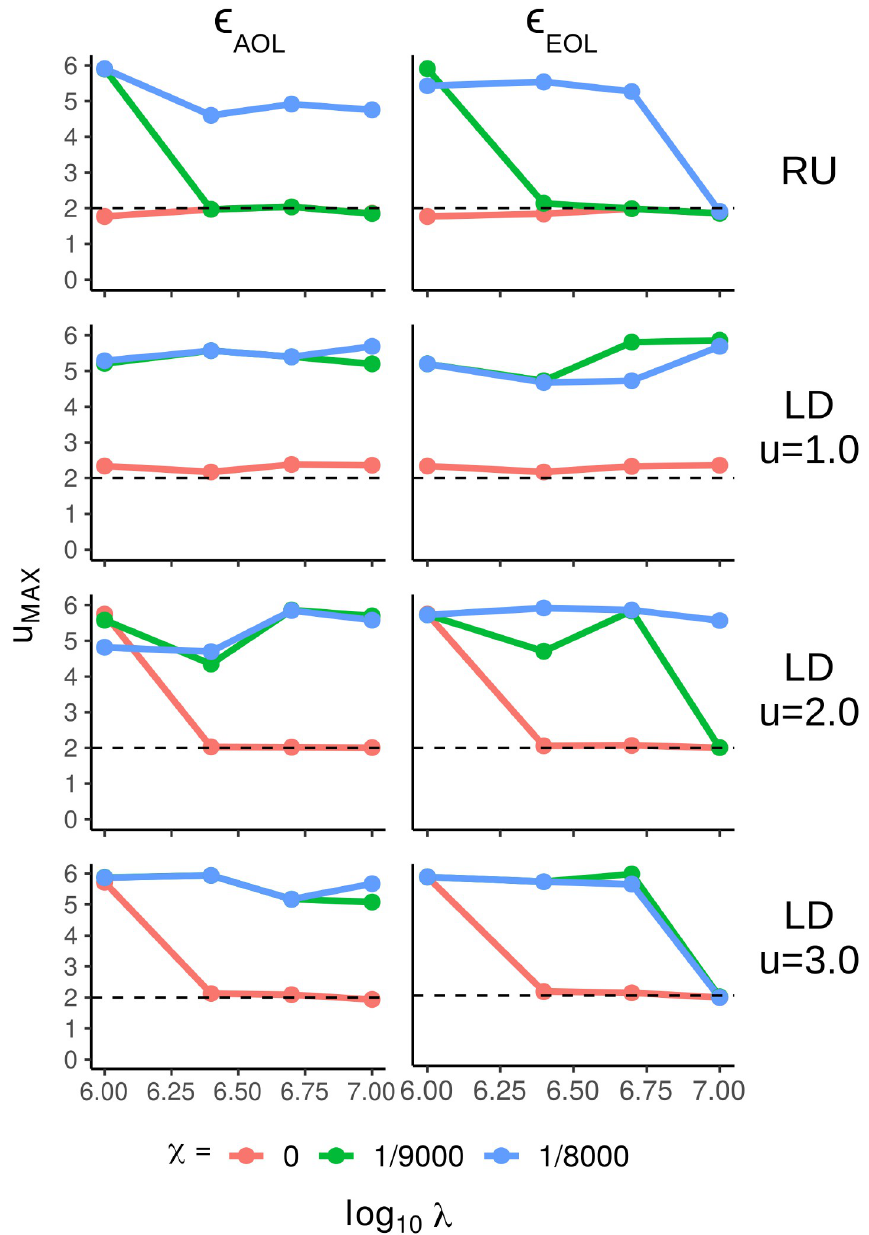
Fig 7. Optimal foraging exponents. The exponent which maximizes fitness, u of the positive-only first moments from the 5 � 10 4 after applying searching costs ( χ = 0 [pink], χ = 1/9000 [green], χ = 1/8000 [blue]), as a function of log 10 lifespan λ . The left column is the average of energy over a lifespan, � column is energy at the end of a lifespan, � EOL , and the rows are indexed by the resource distribution type (RU = Random Uniform, LD = Le´vy Dust where u − 1 = fractal